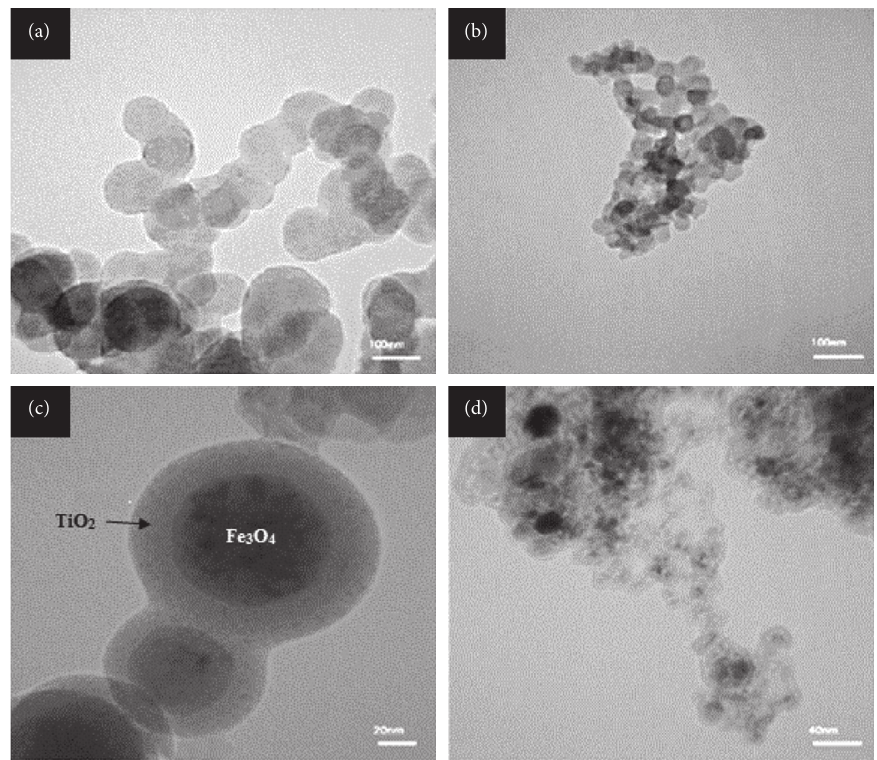
Figure 5: TEM images of the NPs prepared: without applying a magnetic field and the LASER fluence: (a) 30mJ/cm 2 and (b) 60mJ/cm 2 ; with applying a magnetic field and the LASER fluence: (c) 30 mJ/cm 2 and (d) 60mJ/cm 2 .